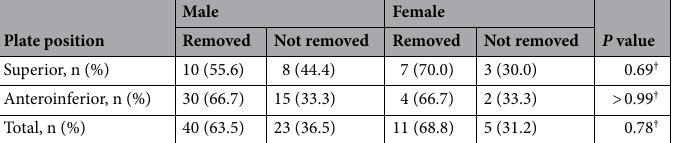
Table 4. Implant removal rates by gender and plate position. † : Fisher exact test.